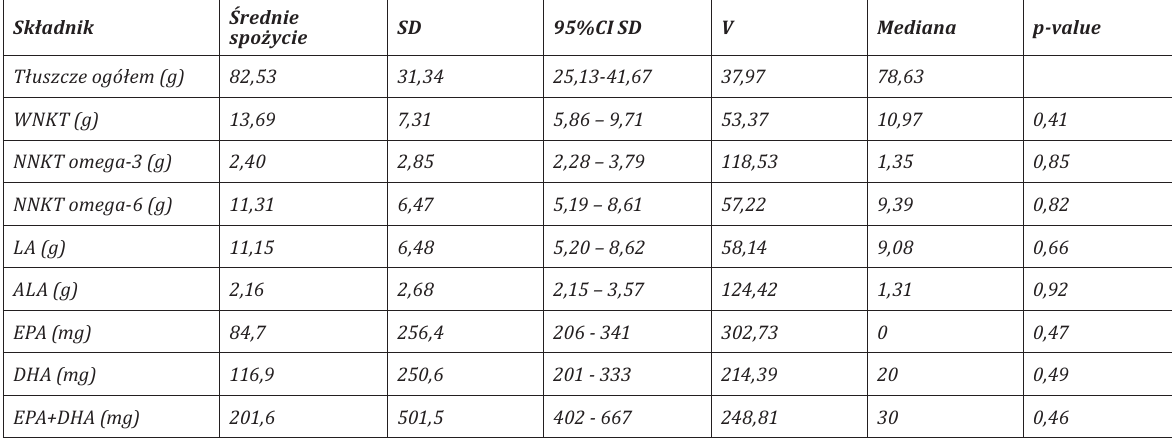
Tabela 5. Spożycie tłuszczu w badanej populacji